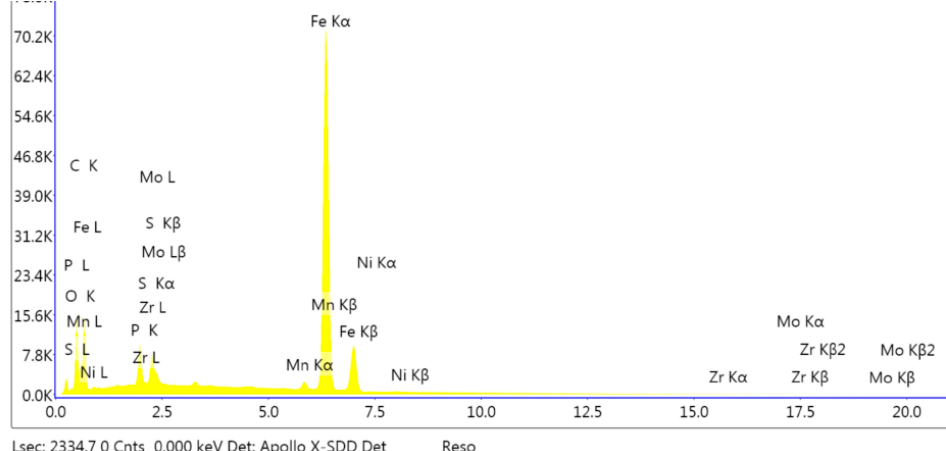
Figure 3. EDS spectrum of the sample modified with molybdenum.